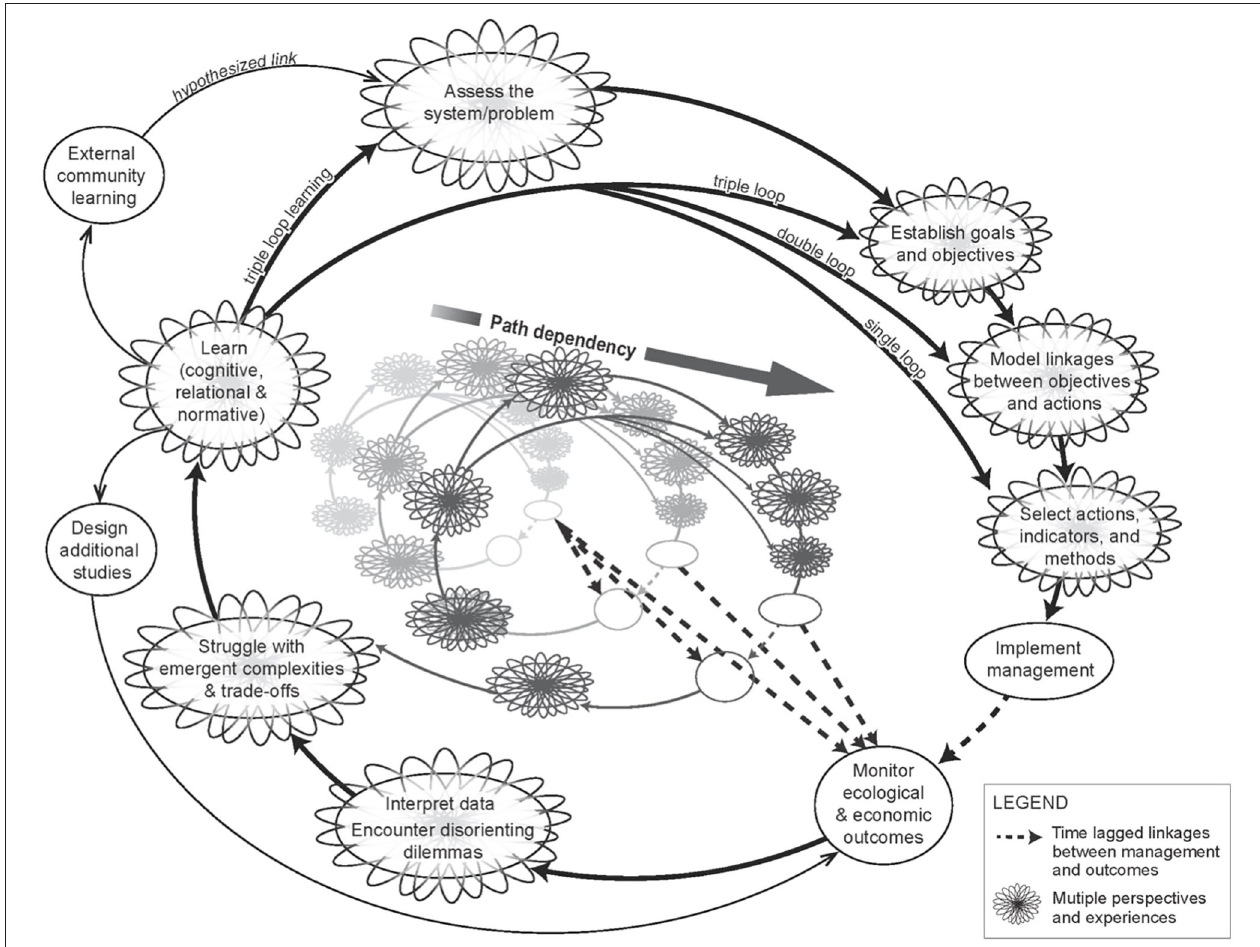
FIGURE 2 | Collaborative adaptive management cycle undertaken by the Colorado (CARM) case, showing single to triple loop learning, as well as disorienting dilemmas, emergent complexities, trade-offs and path dependency, figure from Fernández-Giménez et al.